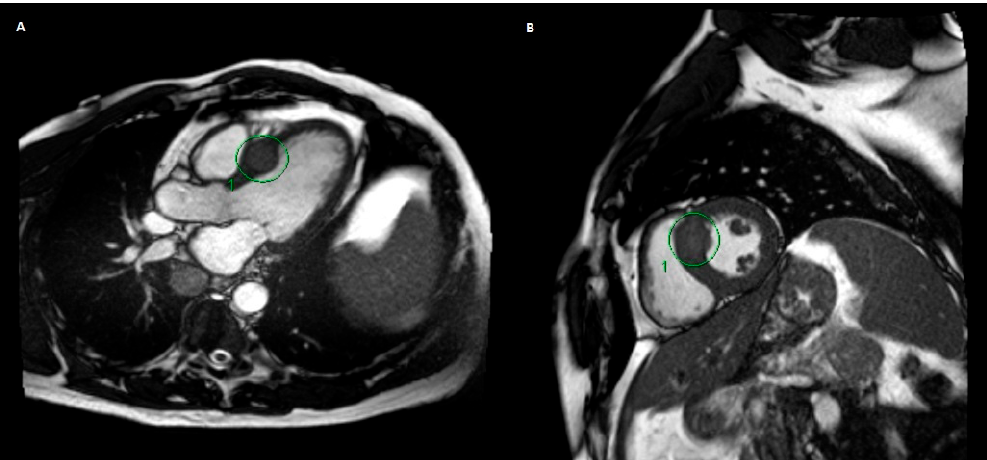
Figure 3. MRI of the thorax and upper abdomen done three months after radiation treatment, showing stability of the metastatic myocardial lesion (circled). No gadolinium contrast was used for this scan, as the patient had an acute kidney injury at the time. Representative axial ( A ) and sagittal ( B ) images are shown on the left and right,